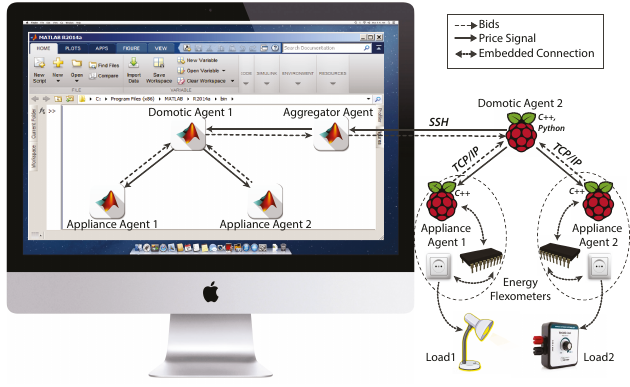
Fig. 6. Setup of multi-agent system in Lab.